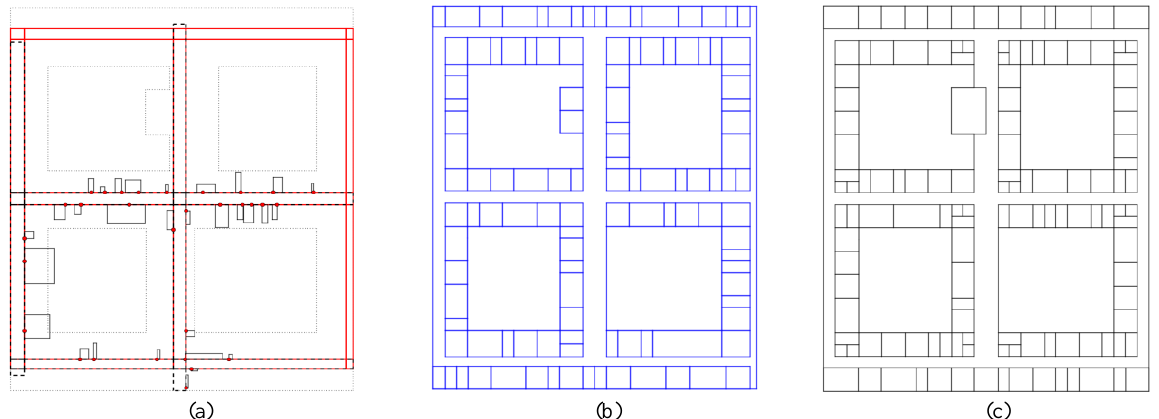
Figure 5. 2nd floor of university building. (a) hallways (dotted polygons) and rooms with door positions (small polygons) derived from traces, hypothesized hallways (red solid polygons); (b) complete model with hypothesized rooms; (c) ground